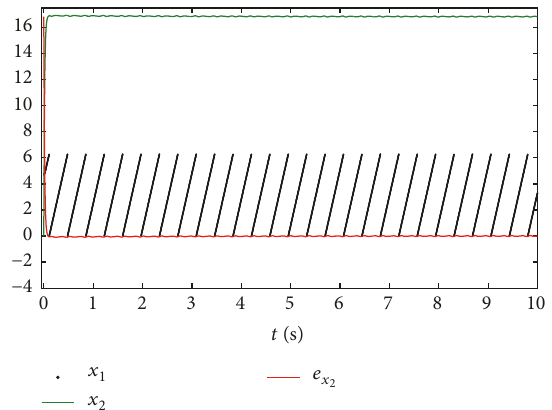
Figure 11: Double-cylinder with PD control by position and constant velocity ( 𝑥 2∗ = 16.83 rad/s = 20